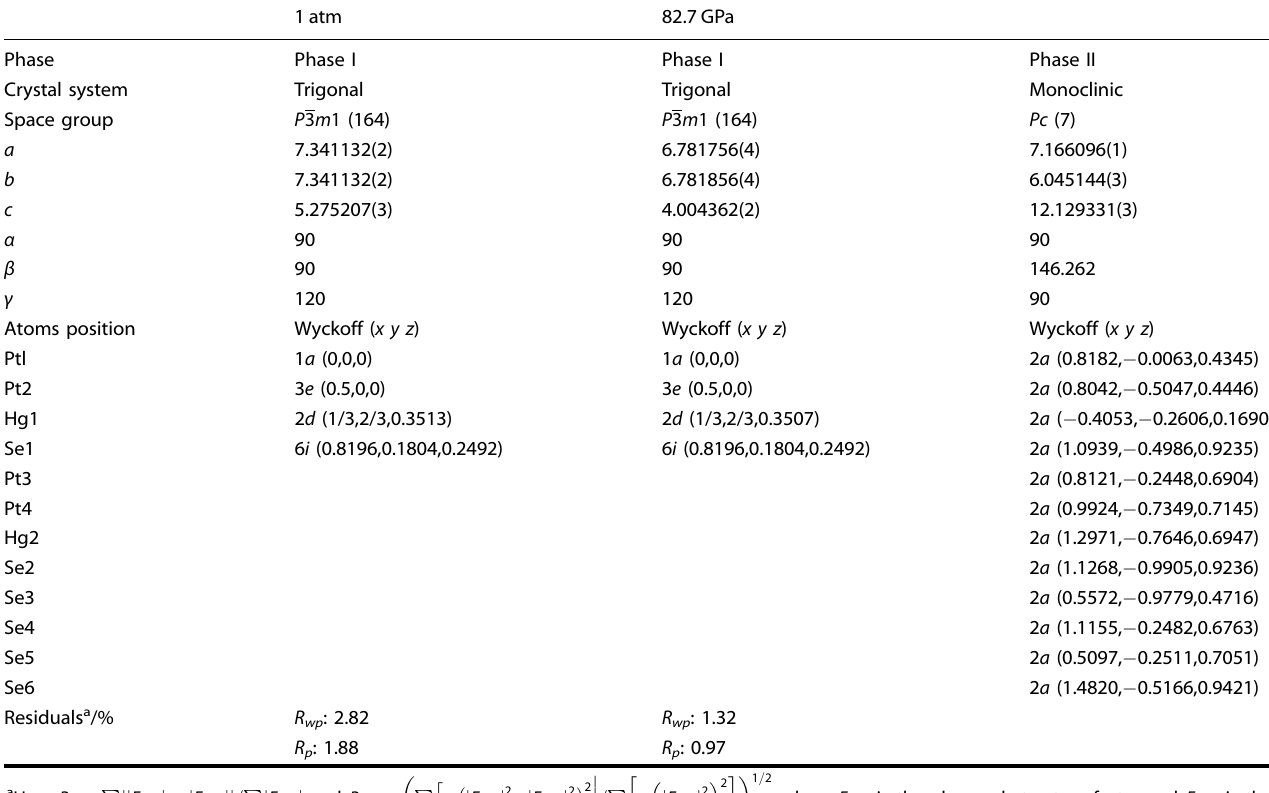
Table 1. Structures of Pt 2 HgSe 3 in phase I and phase II. Structural parameters of Pt 2 HgSe 3 under different pressures at room temperature.